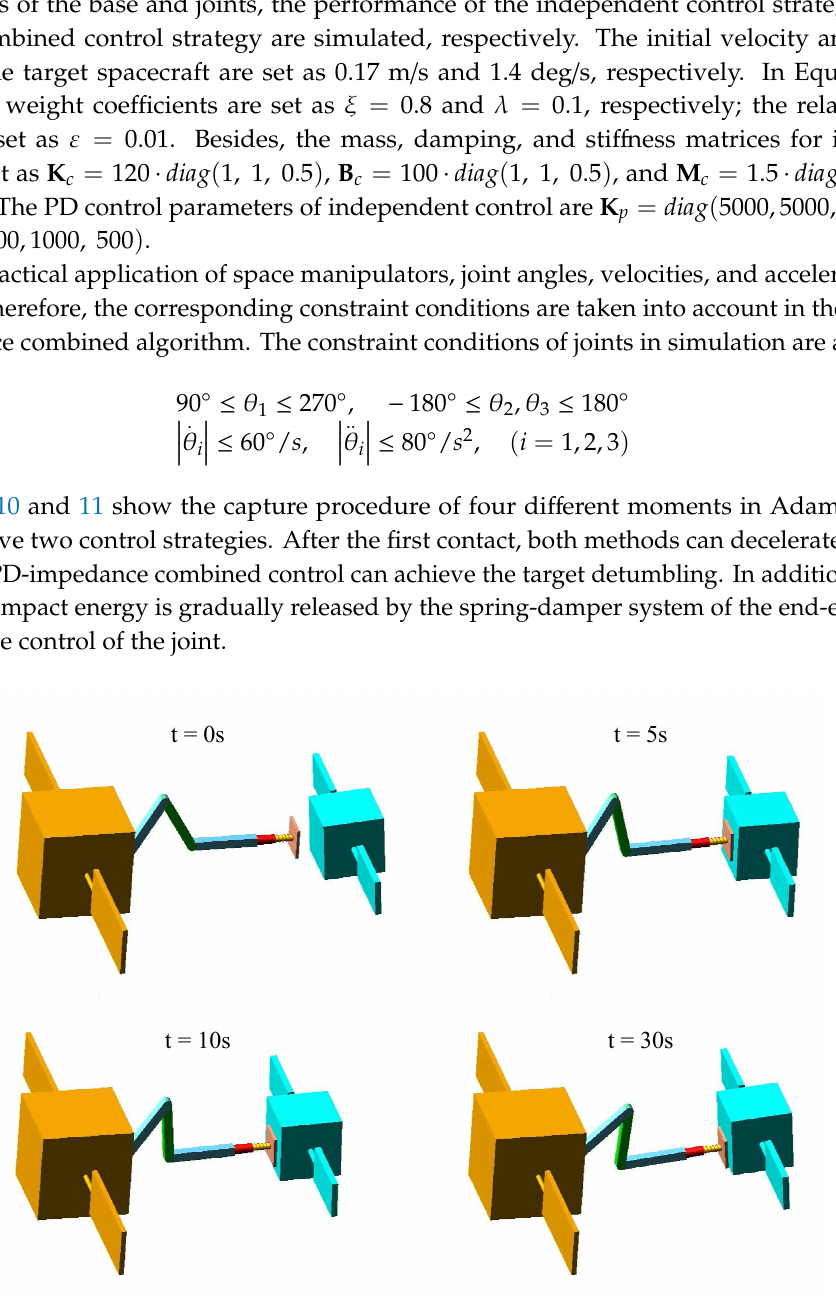
Figure 10. The chaser and target spacecraft during the contact phase using PD-impedance combined control strategy.